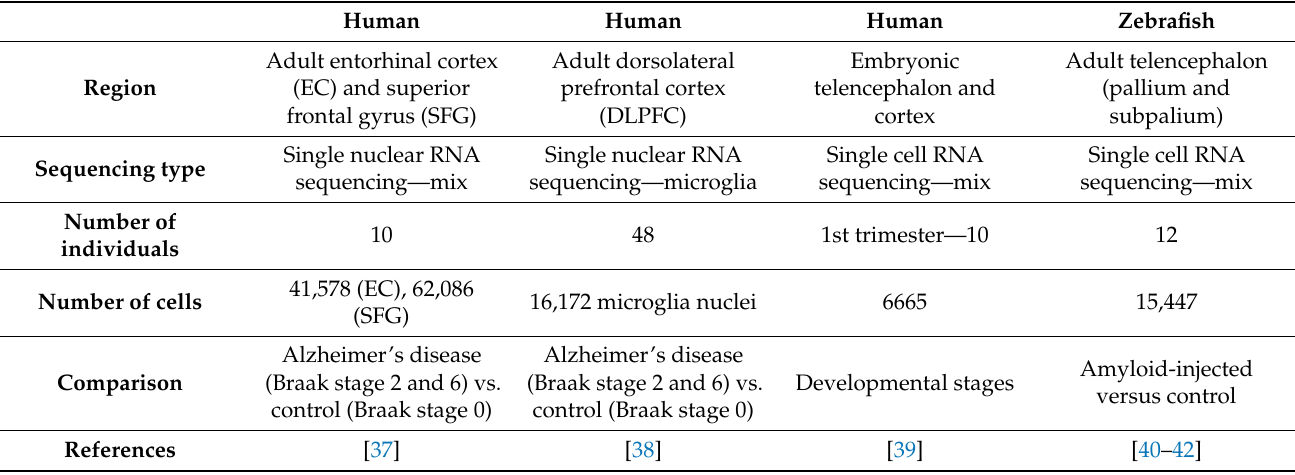
Figure 1. Overall study scheme. Summary of the single cell dataset comparison, conclusions drawn, and respective figures. Table 1. Demographics of the datasets used in this study.